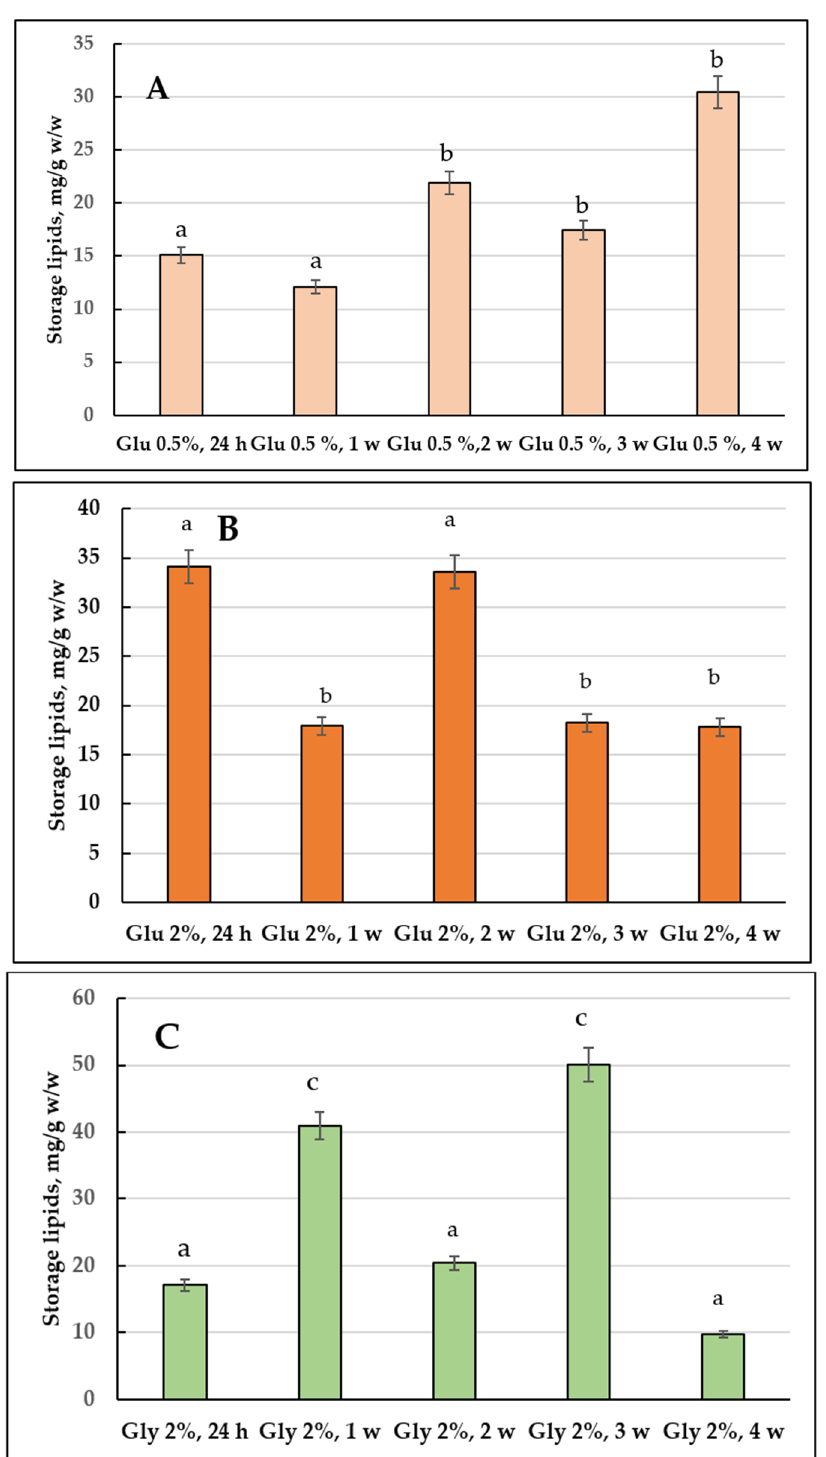
Figure 2. The storage lipid composition in the E.magnusii yeast grown on the different substrates. The share of each storage lipid fraction, %; ( A ) glucose 0.5%; ( B ) glucose 2%; ( C ) glycerol 2%. Error bars represent the standard deviation of triplicates. Mean values are displayed (n = 3, ±SD). a— p < 0.04; b— p < 0.01; c— p < 0.02.